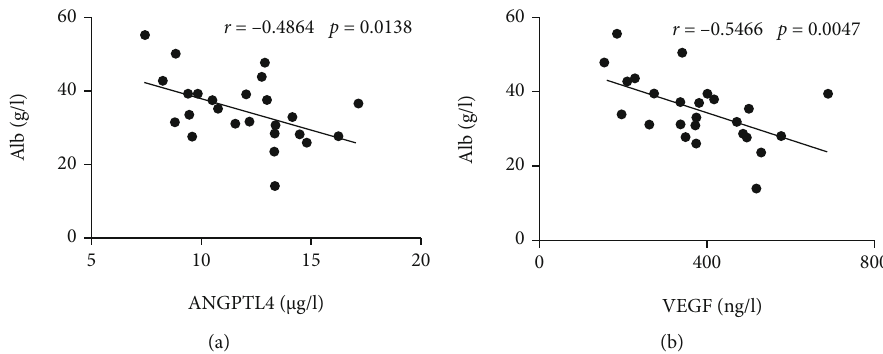
Figure 5: The relationship between ANGPTL4 or VEGF and albumin in KD. (a) Correlation of levels between ANGPTL4 and albumin in KD patients. (b) Correlation of levels between VEGF and albumin in KD patients. Pearson ’ s test was performed to explore the